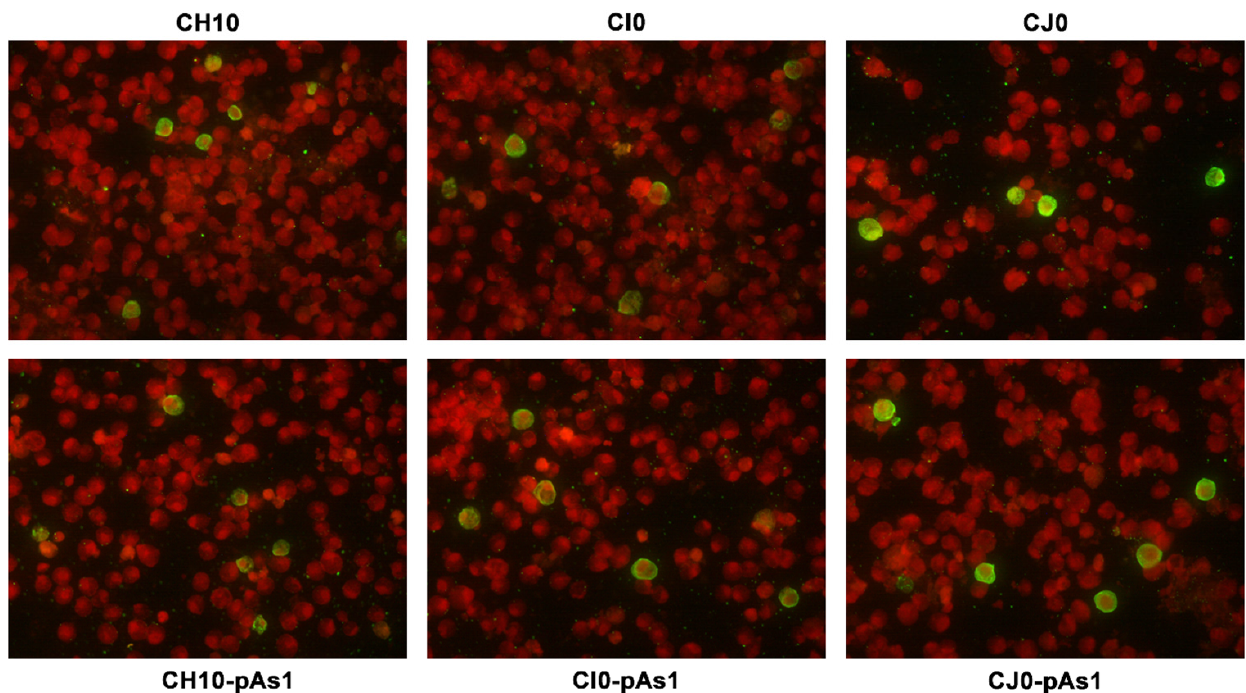
Figure 4. UT7/EpoS1 cells transfected with the indicated inserts were sampled at 24 hpt, and NS1 protein was detected by IIF. Original magnification 400×.